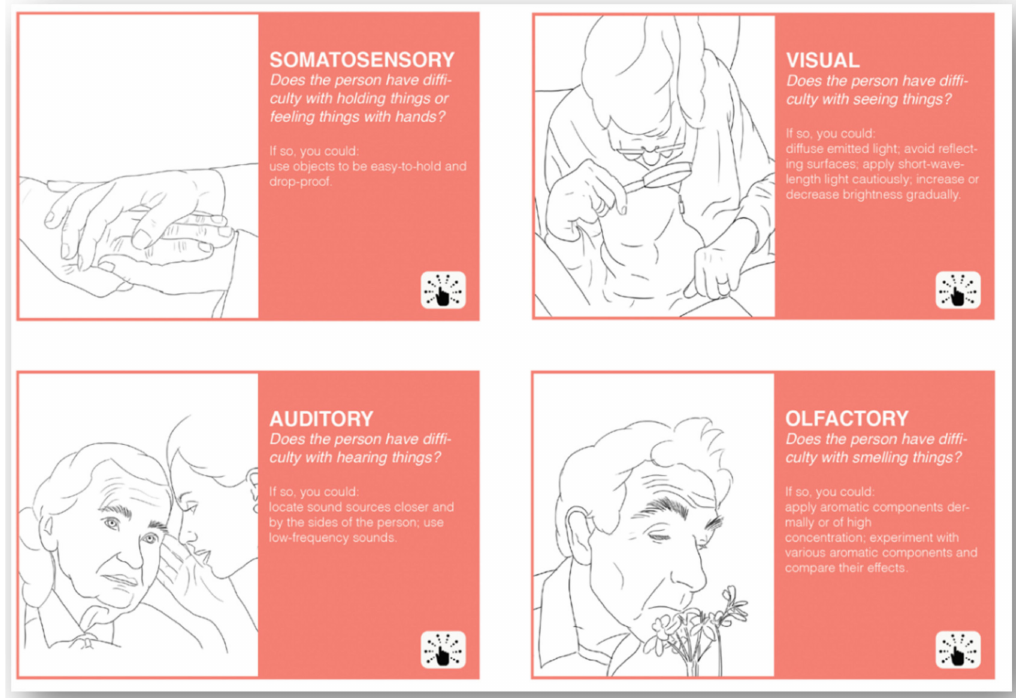
Figure 3. The cards for sensory-oriented